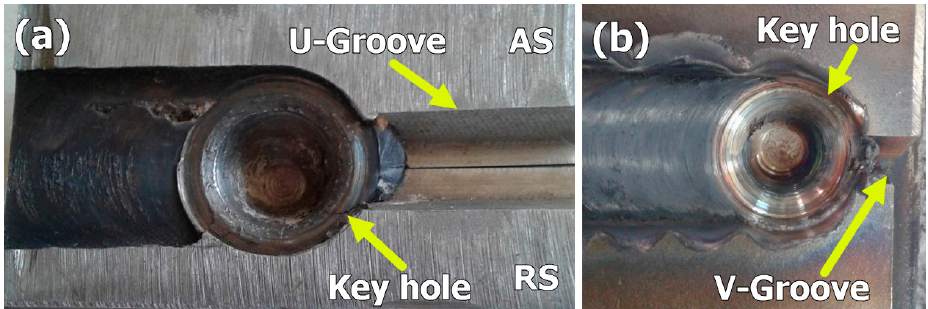
Figure 4. Key hole after FSW of 2205 DSS ( a ) U shape groove with root. ( b ) V shape groove without root.